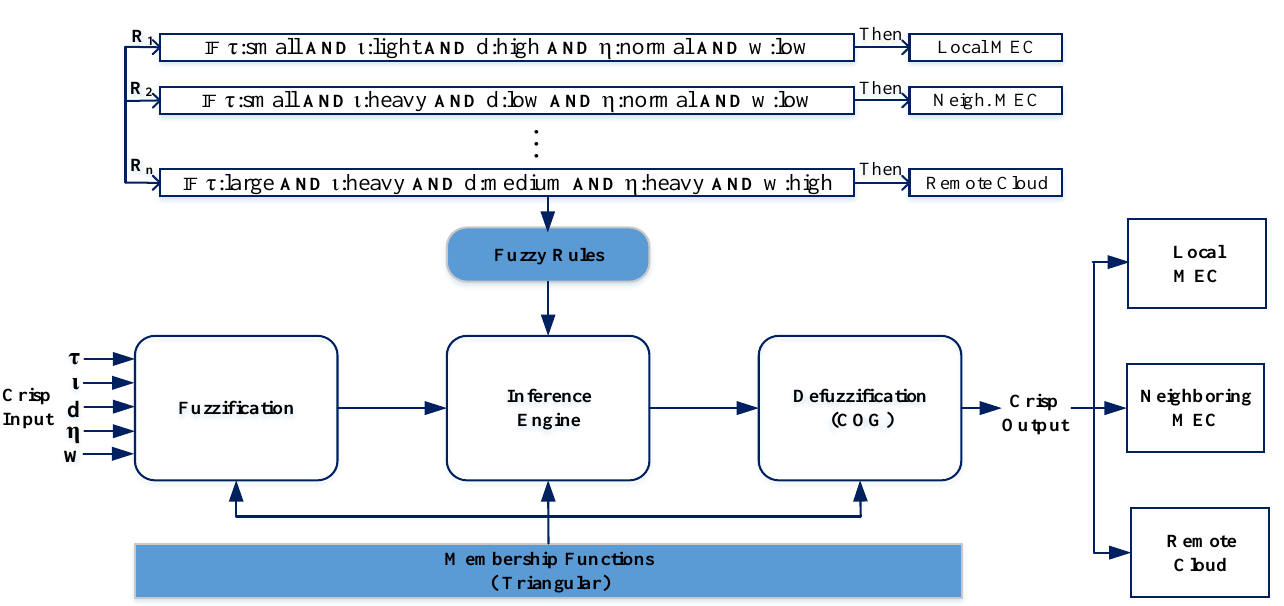
Figure 6. The proposed fuzzy logic